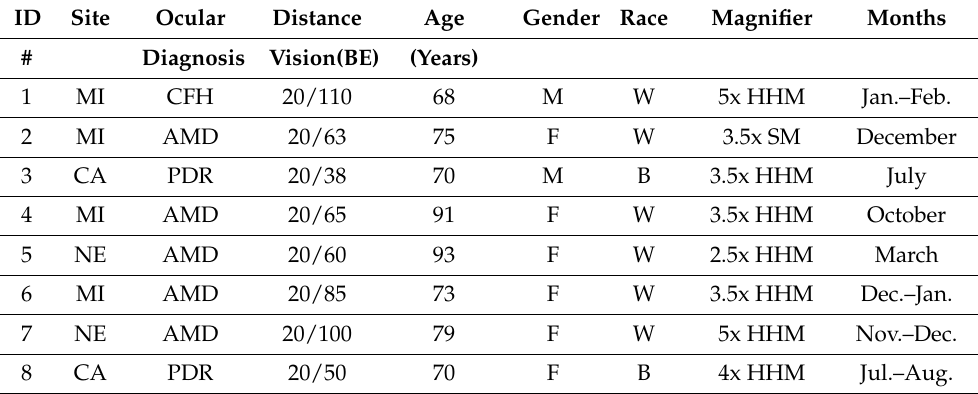
Table Abbreviations: BE = better eye; MI = Michigan: Mid-Michigan Eye Care; CA = California: Univer- sity of California, Los Angeles; NE = Nebraska: University of Nebraska Medical Center; CFH = congeni- tal foveal hypoplasia; AMD = age-related macular degeneration; PDR = proliferative diabetic retinopathy; F = female; M = male; W = white; B = black or African American; HHM = (illuminated) handheld magnifier; SM = (illuminated) stand